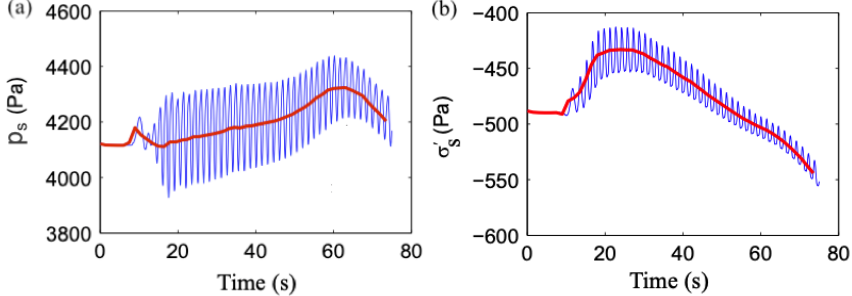
Figure 5. ( a ) The temporal evolution of the wave induced pore pressure, p s ; ( b ) effective normal stress of the soil in front of a composite vertical breakwater, σ (cid:48) s (adapted from Ye et al.